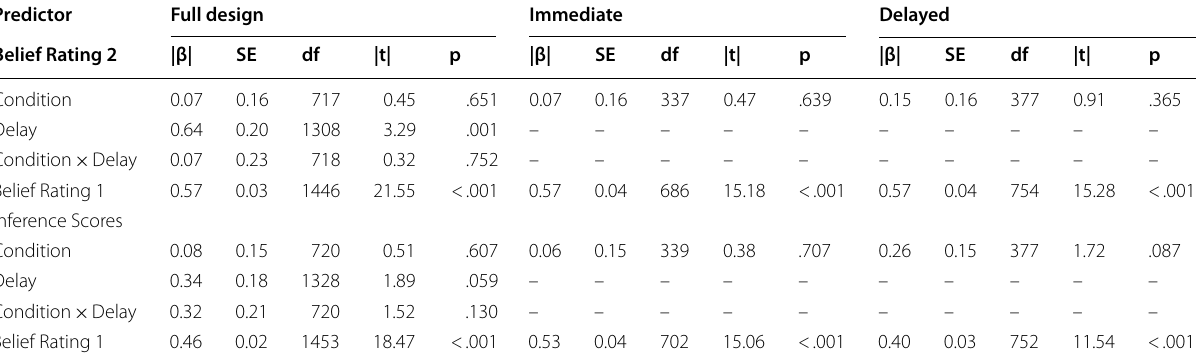
Table 5 Linear mixed-effects modeling results in Experiment 3